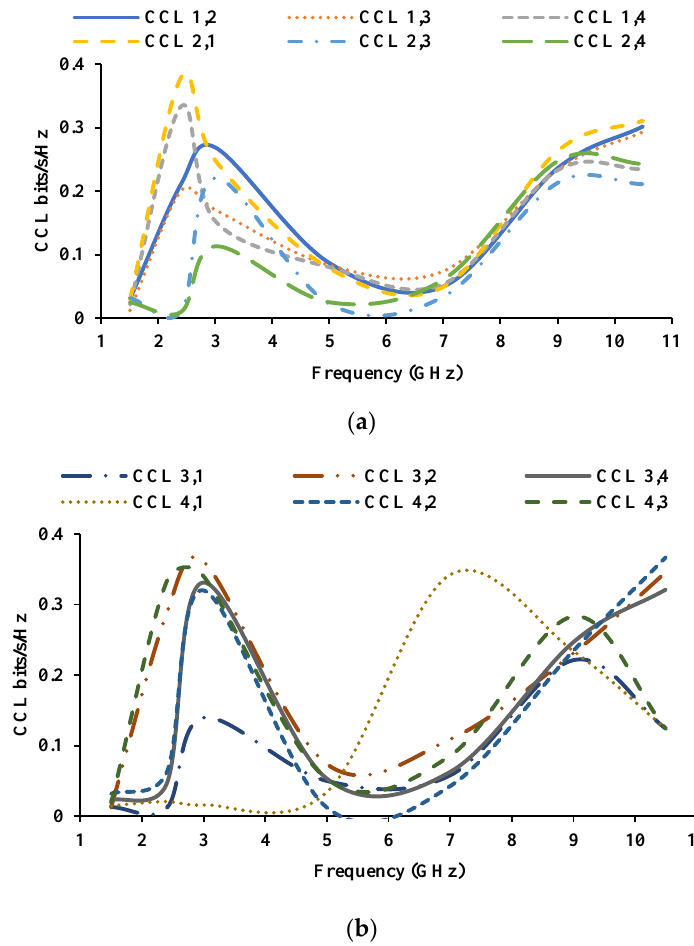
Figure 17. CCL of the proposed antenna ( a ) with respect to port 1 and port 2, ( b ) with respect to port 3 and port 4.